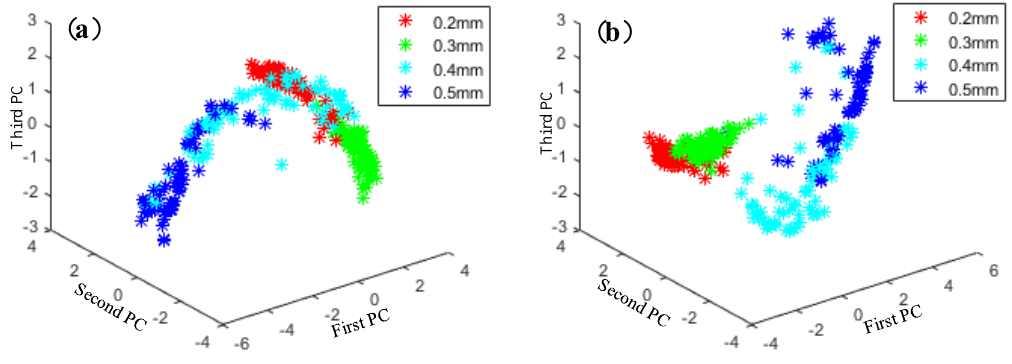
Feature visualization of various roller fault degrees: ( a ) raw data features and ( b ) proposed method.